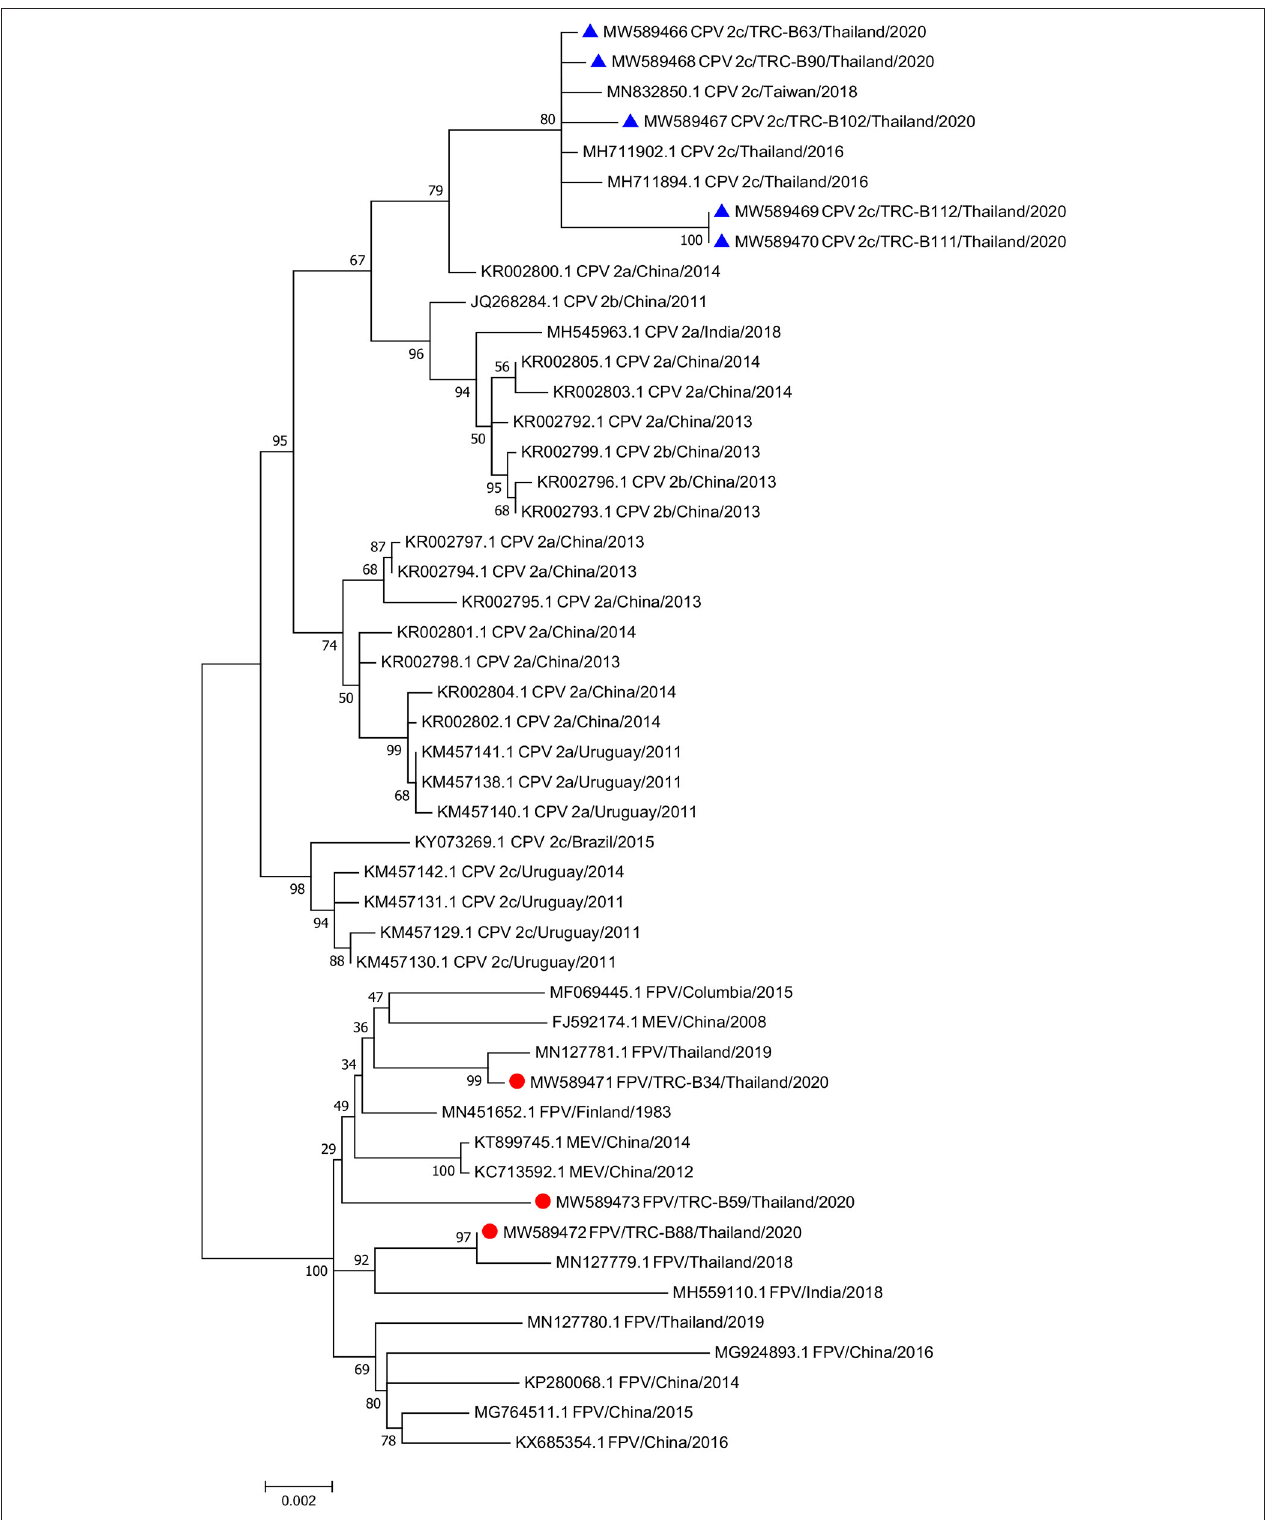
FIGURE 1 | Phylogenetic tree of the complete genome sequences of feline parvovirus (FPV) and canine parvovirus (CPV) obtained from three cats and five dogs in this study and the available sequences from GenBank. Sequences from cats are labeled as (•) while sequences from dogs are labeled as ( N ).